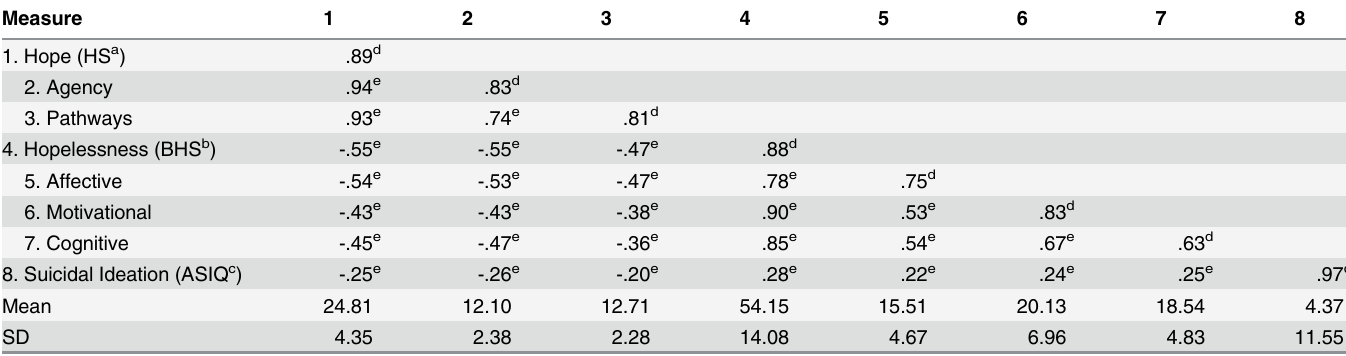
Table 2. Means, Standard Deviations, Cronbach ’ s Alphas, and Intercorrelations of Study Variables.